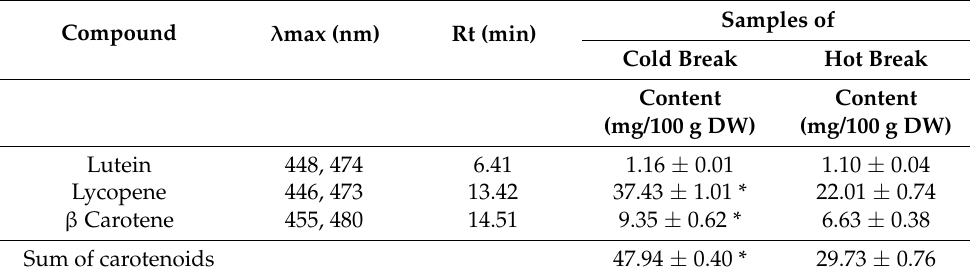
Table 3. Individual and sum of carotenoids identified in tomato seed oil derived from cold break and hot break processing lines, expressed as mg β -carotene/100 mL oil; analytical measurements were conducted with three replicates ( n =